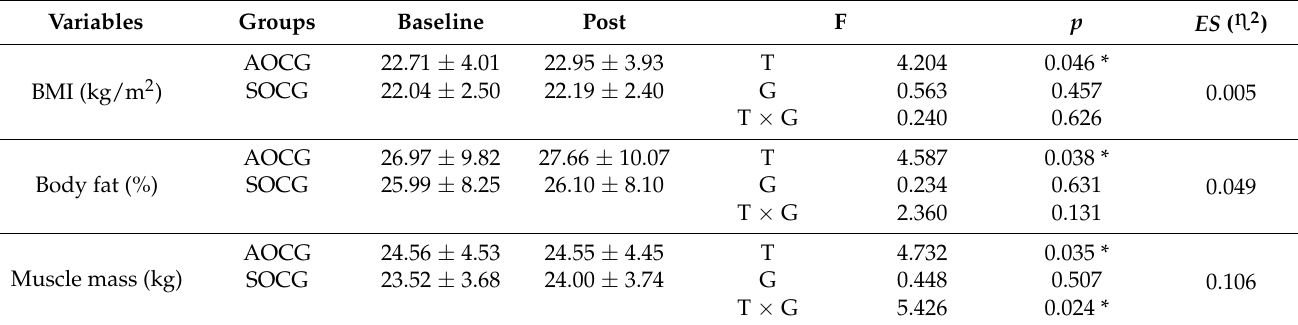
Table 1. Changes in body composition.